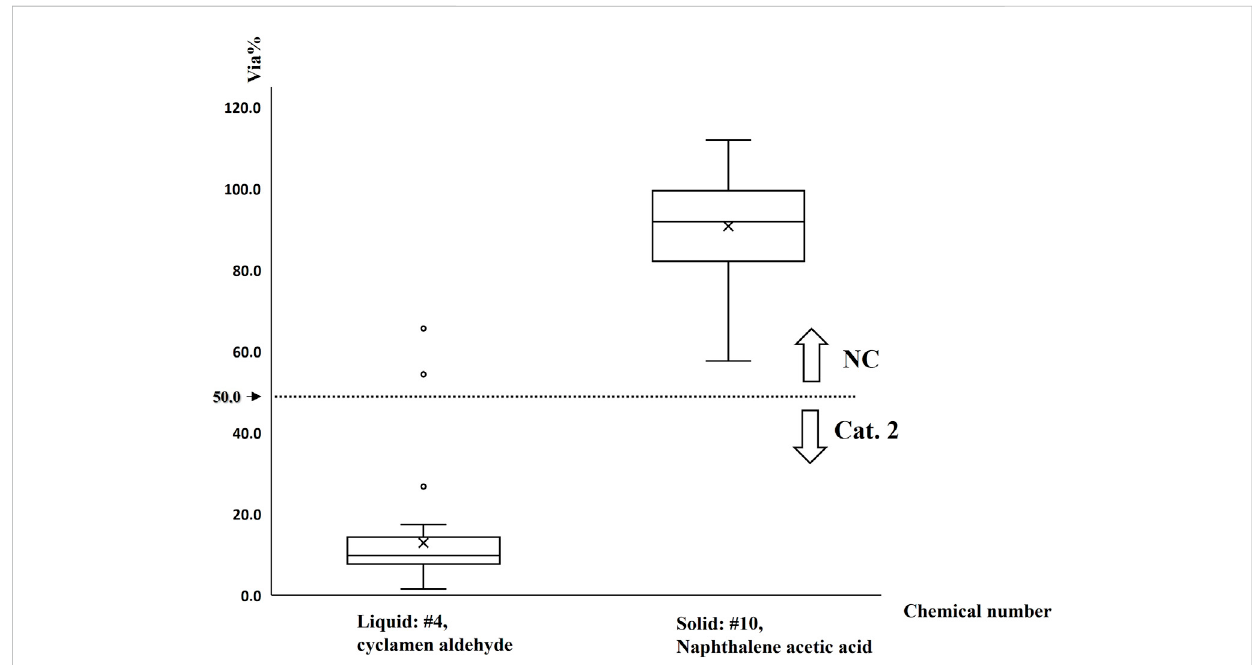
FIGURE 9 Distribution of mean cell viabilities of chemicals considering 38 quali fi ed runs of test in fast-learning classes line within box: median; lower borderline of box: 25th quartile; upper borderline of box: 75th quartile; hollow dots: outside